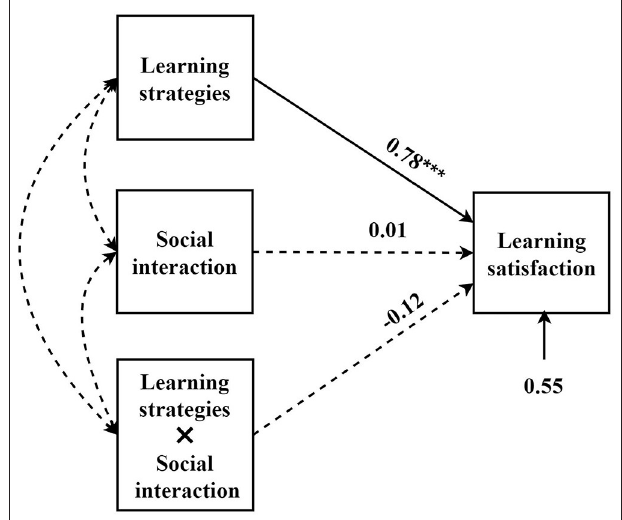
FIGURE 3 | The influence of learning strategies on learning satisfaction: a moderating model of behavioral engagement. ** p < 0.01, *** p < 0.001.